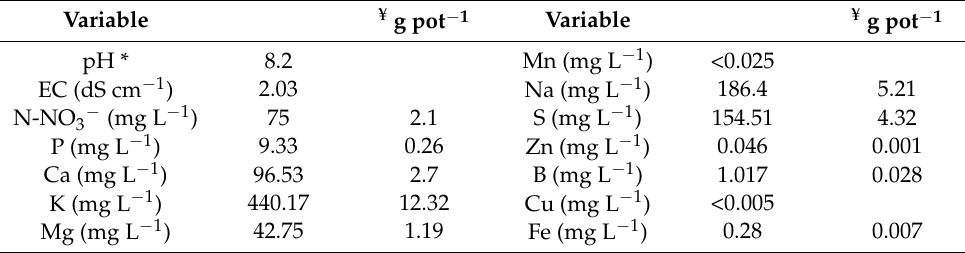
Table 4. Chemical characteristics and mineral composition of vermicompost tea applied in organic